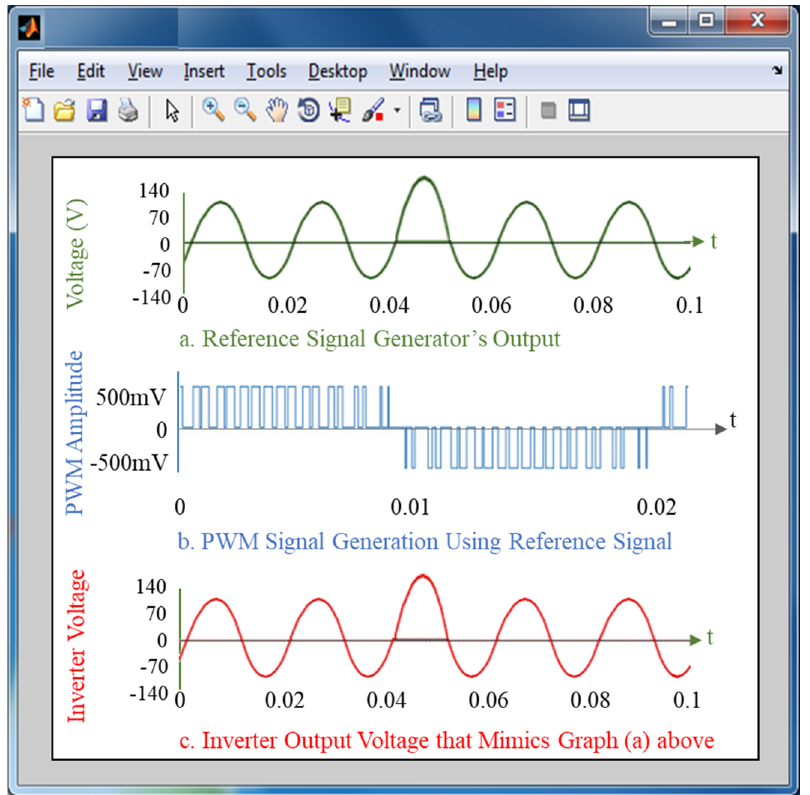
Figure 6. ( a ) Reference signal generator’s output. ( b ) PWM signal generation using reference signal. ( c ) Inverter output voltage that mimics (a).